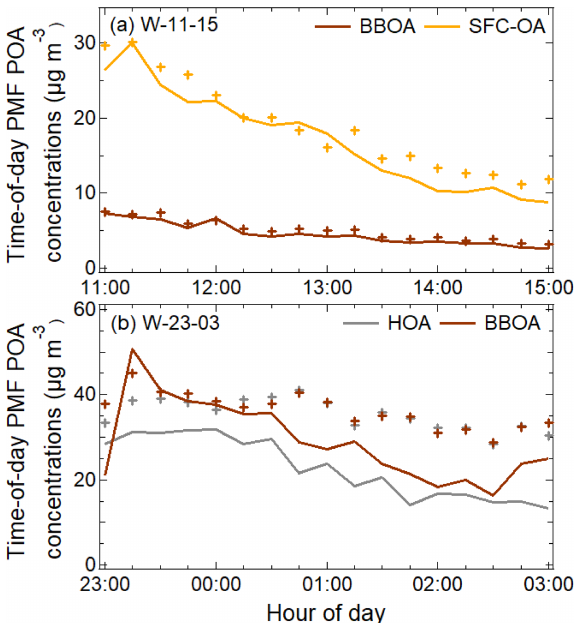
Figure 3. The 15min averaged seasonally representative mean ( + ) and median concentrations (lines) of time-of-day PMF primary fac- tors for the periods (a) W-11-15 and (b) W-23-03 (in µgm − 3 ) . Nighttime factors show evidence of